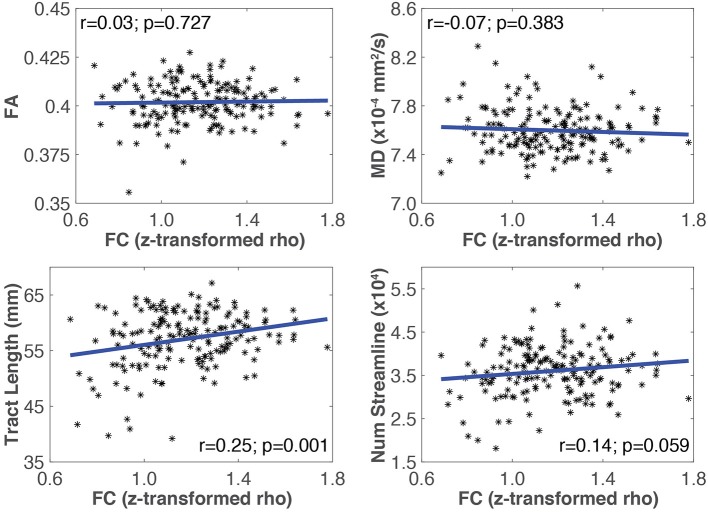
Plots showing the linear relationship between SC (i.e., MD, FA, mean tract length, number of streamlines) and FC measures for the somato-motor network. The Pearson correlation coefficient (r), and the corresponding uncorrected p-value, for each SC measure with FC is also shown. In this network, only mean tract length was significantly correlated with FC.